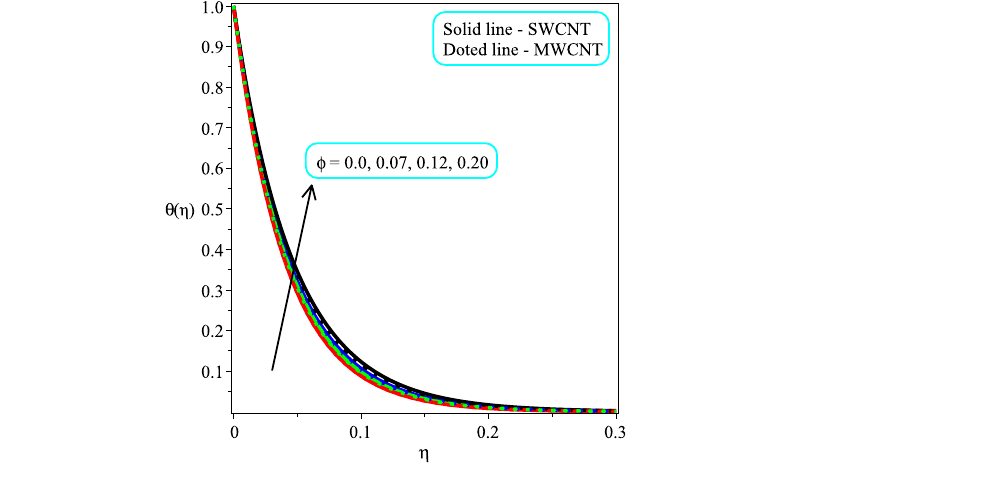
Figure 6. Repercussion of φ with κ = 1 M egt = 2, Ω = 1.5, ω = π /3, N = 10, Υ = 0.4, Pr = 100 on the temperature profile.